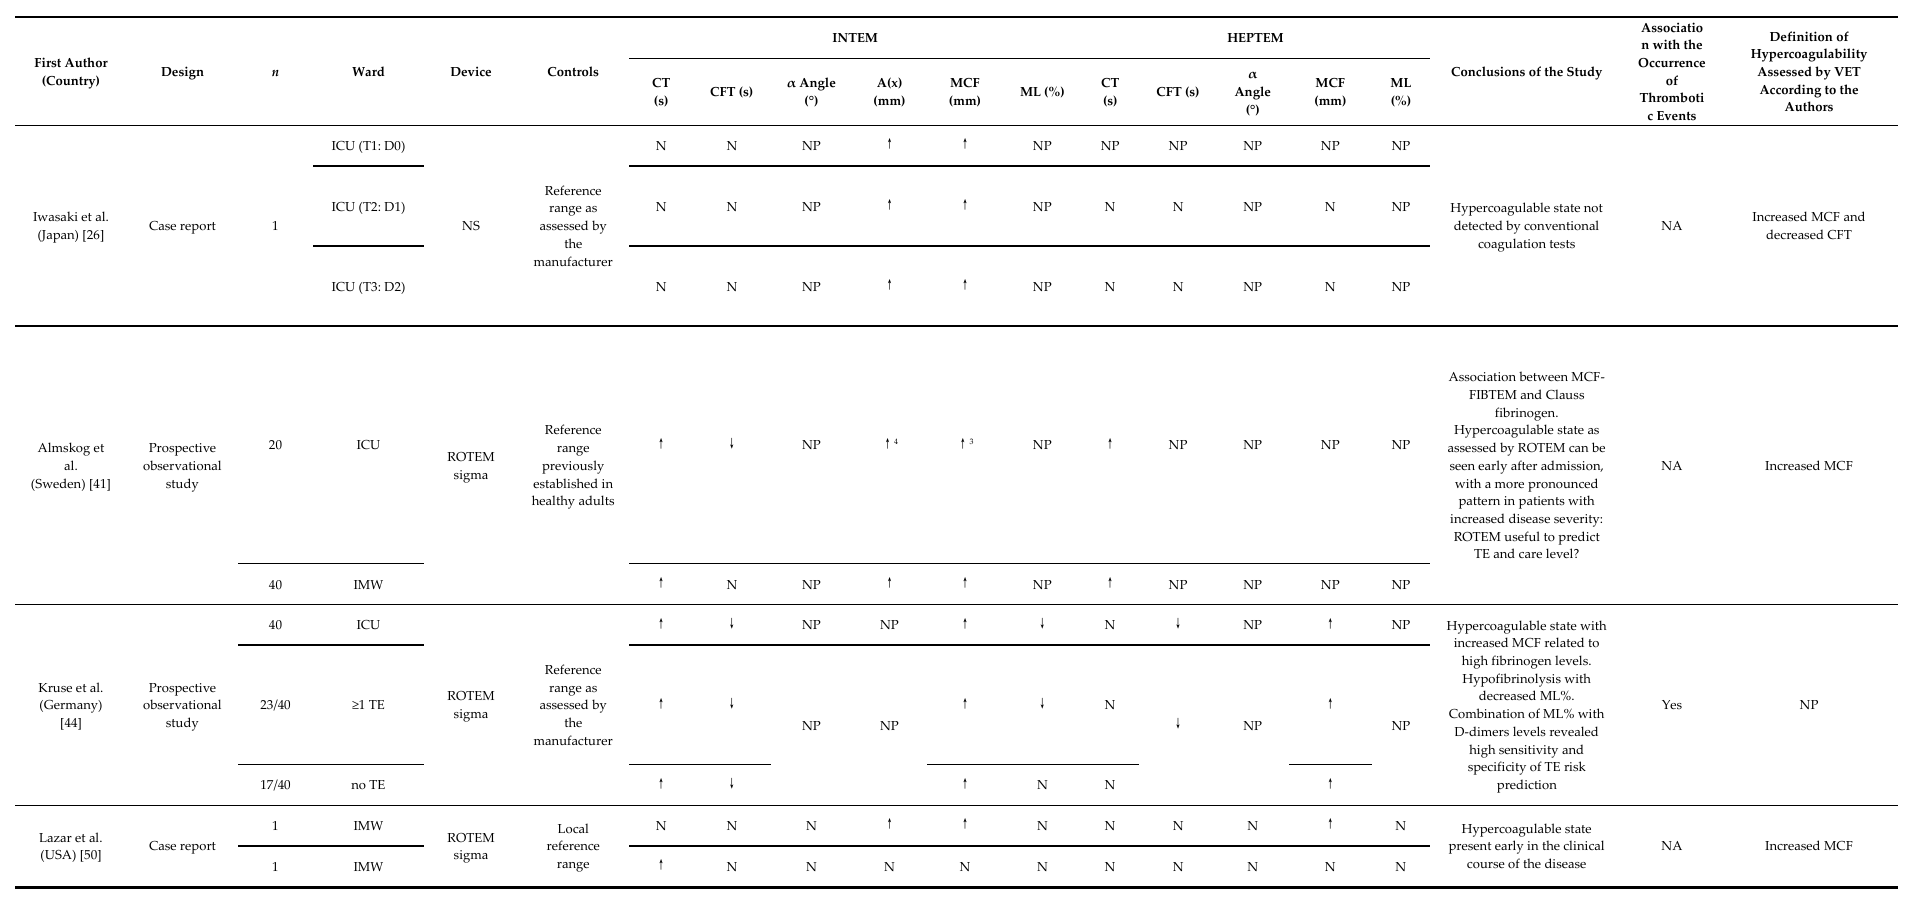
Table 6. Main findings of studies reporting results from the HEPTEM assay